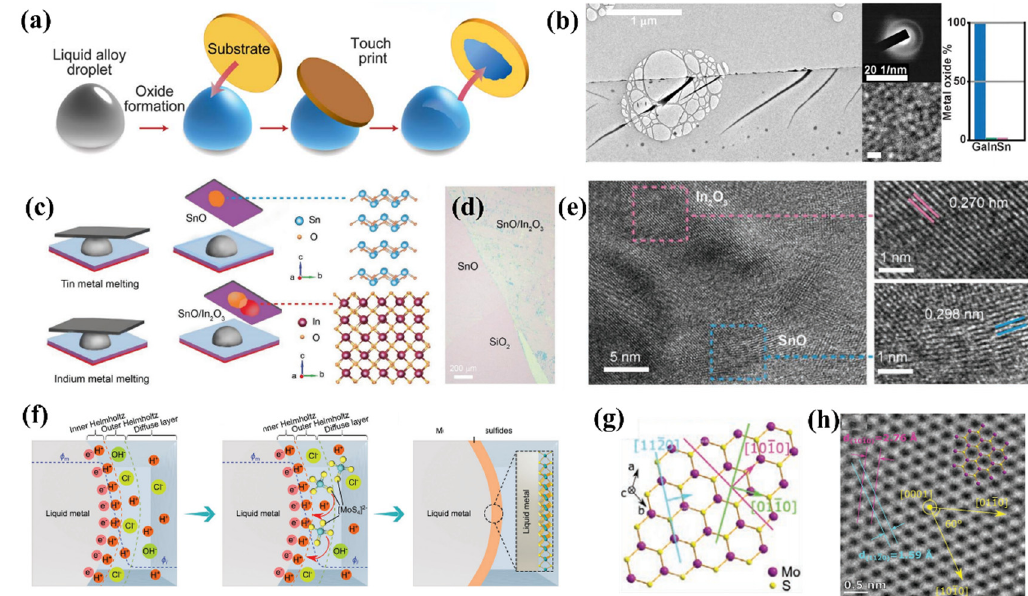
Figure 2. ( a ) Schematic diagram of the sticking method: Applying modified substrate to obtain liquid metal oxide film from liquid metal ( b ) TEM of Ga 2 O 3 thin film and its corresponding SAED and HRTEM images. Reprinted with permission from Ref. [56] Copyright 2017 Science. ( c ) Schematic illustration of the 2D VdW transfer technique of SnO/In 2 O 3 thin films from liquid metal ( d ) Optical image of the 2D SnO/In 2 O 3 heterostructure ( e ) HRTEM image showing a highly crystalline structure with continuous lattice fringes across the SnO/In 2 O 3 heterostructure interface. Reprinted with permission from Ref. [71] Copyright 2019 Advanced Materials Interfaces. ( f ) Schematic illustration of MoS x formation on EGaIn ( g , h ) The crystal structure of MoS 2 sheets. Reprinted with